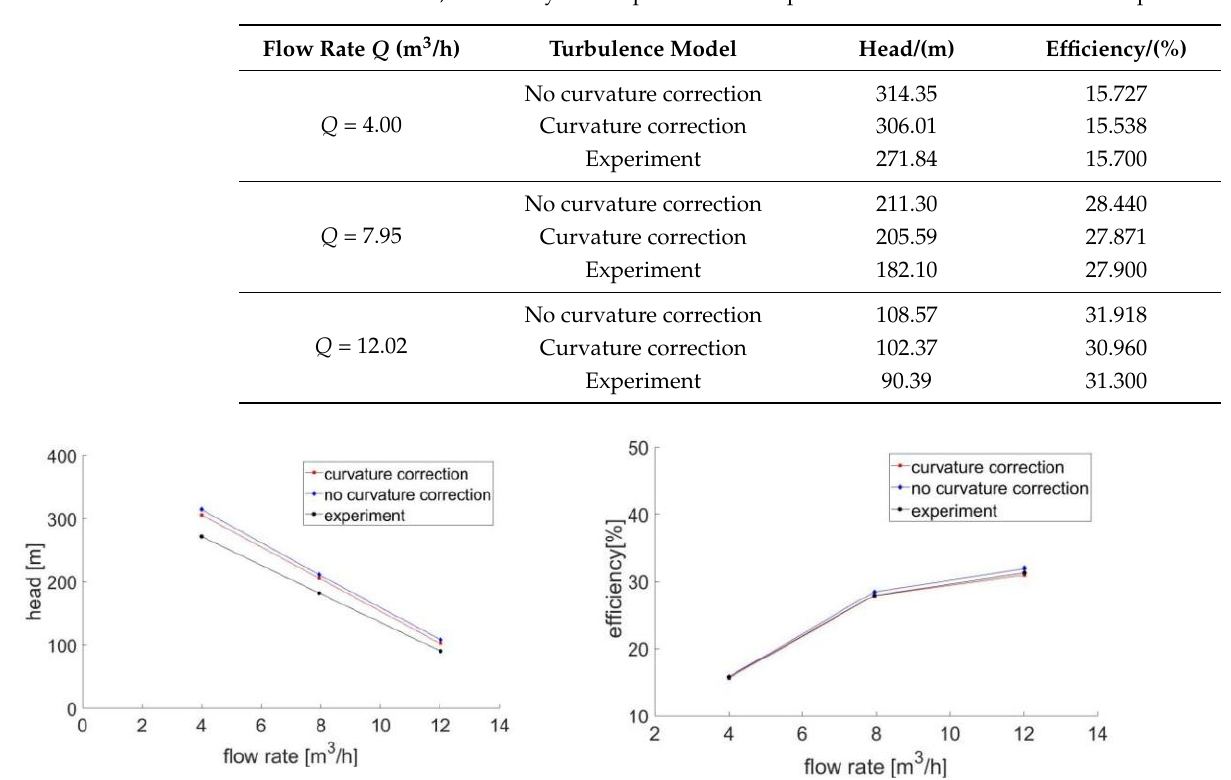
Table 4. The hydraulic performance simulation results based on the DES model, with and without curvature correction, and the hydraulic performance experimental results at different flow points.